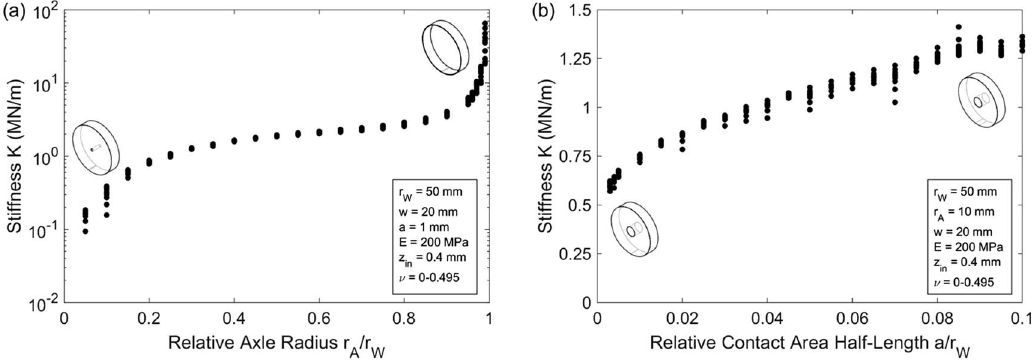
Figure 3. Results of the parametric study: (a) relative axle radius r A = r W and (b) relative contact area half-length a = r W . Points having the same x coordinate (but a different y coordinate) are for varying values of Poisson ’ s ratio m . Schematics of the extreme wheel geometries are shown for reference (drawn to scale with respect to one another).